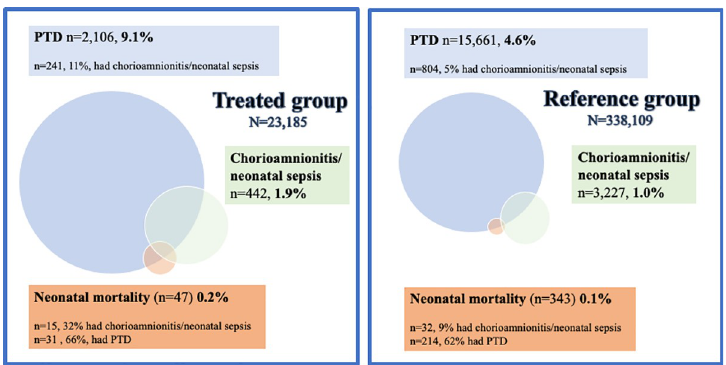
Fig 5. Venn diagram illustrating the relationship between preterm delivery (PTD), infectious complications (chorioamnionitis/neonatal sepsis), and neonatal mortality in the treated group and the reference group. The treated group more frequently had PTD, neonatal mortality, and infectious complications. The deliveries resulting in neonatal mortality more frequently had infectious complications in the treated group than in the reference group.